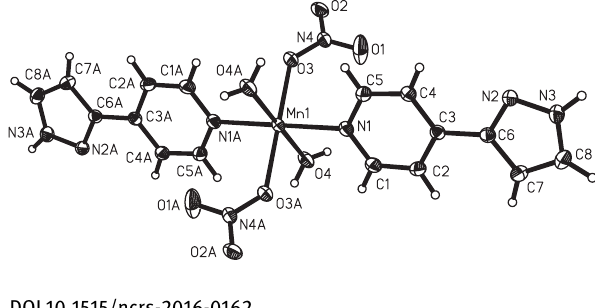
Table 1: Data collection and handling.